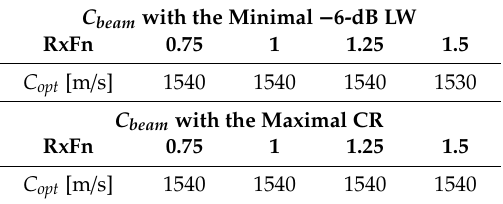
Table 3. C beam with the best image quality